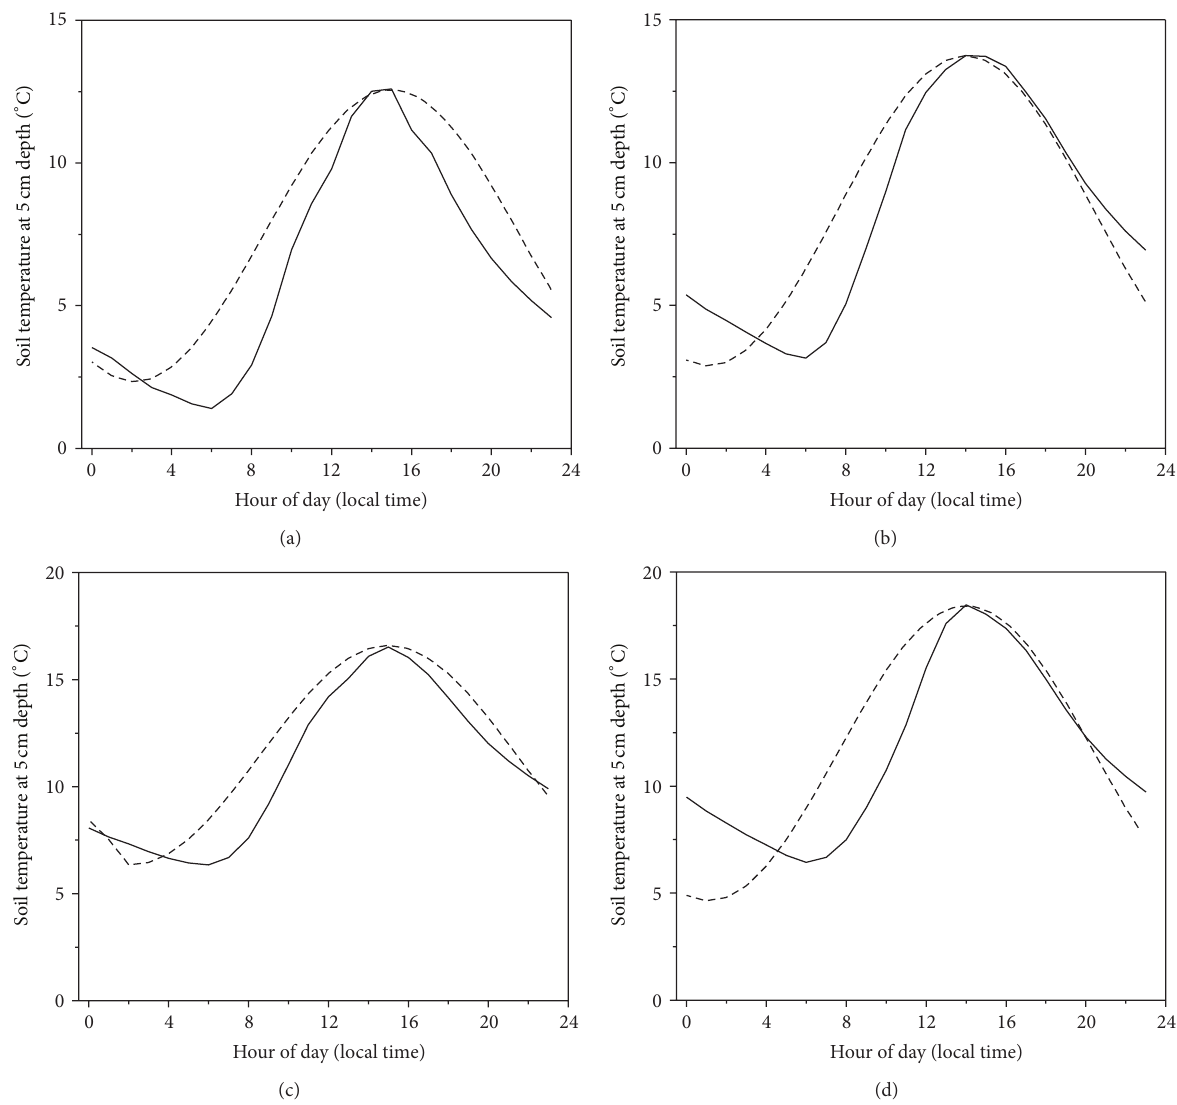
Figure 3: Comparison between 3-day daily mean diurnal soil temperature (solid line, 5 cm) and the corresponding sinusoidal temperature (dashed line) with the same daily range for May (a), June (b), July (c), and August